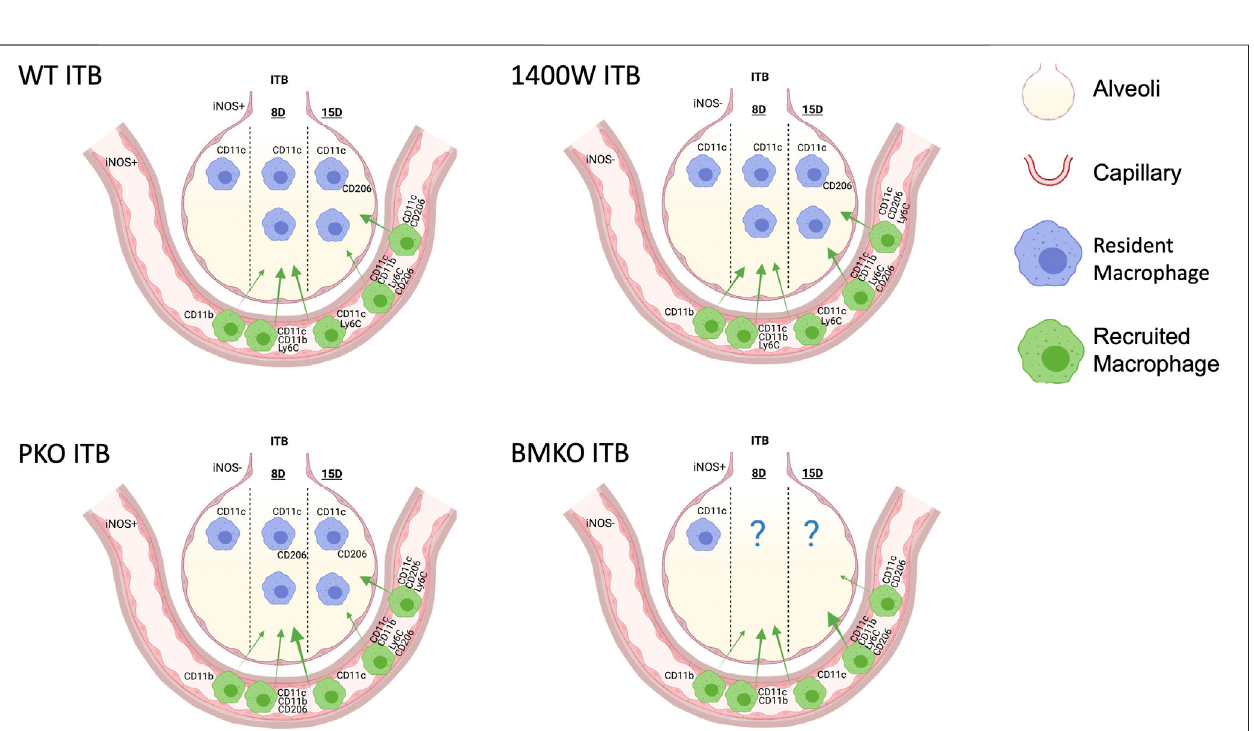
FIGURE 12 | Macrophage activation in lung tissue differs based on iNOS competency. Lungs collected from bleomycin instilled mice also treated with 1400 W or iNOS chimeras are stained for CD11b, COX2, and Ym1. Representative pictures are at 200x. ( n = 4 – 7 per group).